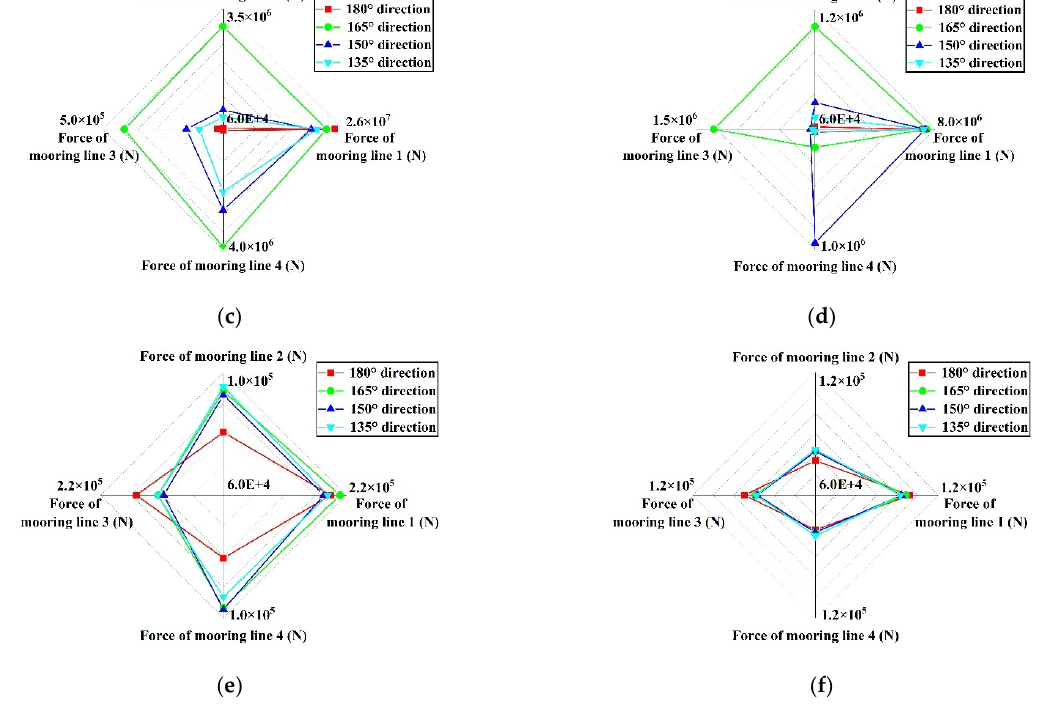
Figure 14. Tension comparison of four mooring lines under different load directions. ( a ) Maximum tension of mooring lines under wave loads; ( b ) mean tension of mooring lines under wave loads; ( c ) maximum tension of mooring lines under level ice loads; ( d ) mean tension of mooring lines under level ice loads; ( e ) maximum tension of mooring lines under broken ice floes loads; ( f ) mean tension of mooring lines under wave loads.